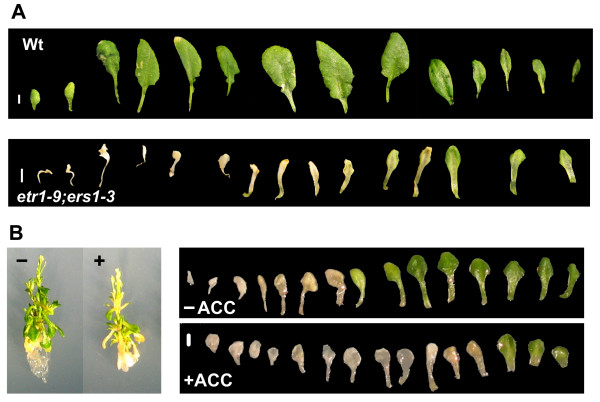
Accelerated senescence of leaves from etr1;ers1 mutant plants. A, Leaves of five-week-old etr1-9;ers1-3 and wild-type plants showing differences in senescence. B, Increased senescence of etr1-7;ers1-2 leaves upon treatment with the ethylene precursor ACC. Five-week-old plants are shown, the ACC treatment (+) being for 27 days with 50 μM ACC. Scale bars equal 1 mm.